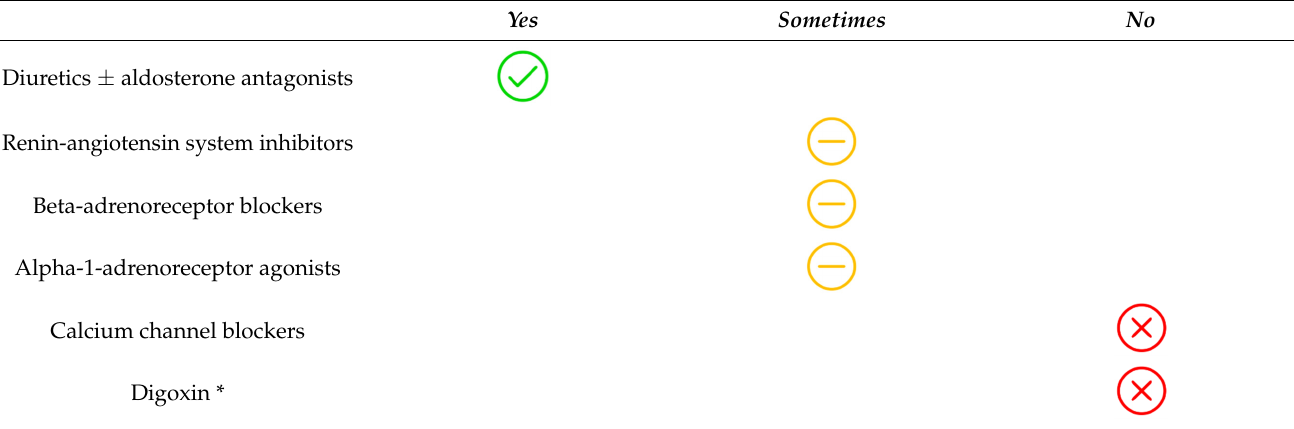
Table 1. The use of standard heart failure therapies in transthyretin amyloid cardiomyopathy. * except for pulse control in uncontrollable tachyarrhythmia absoluta . Yes Sometimes No